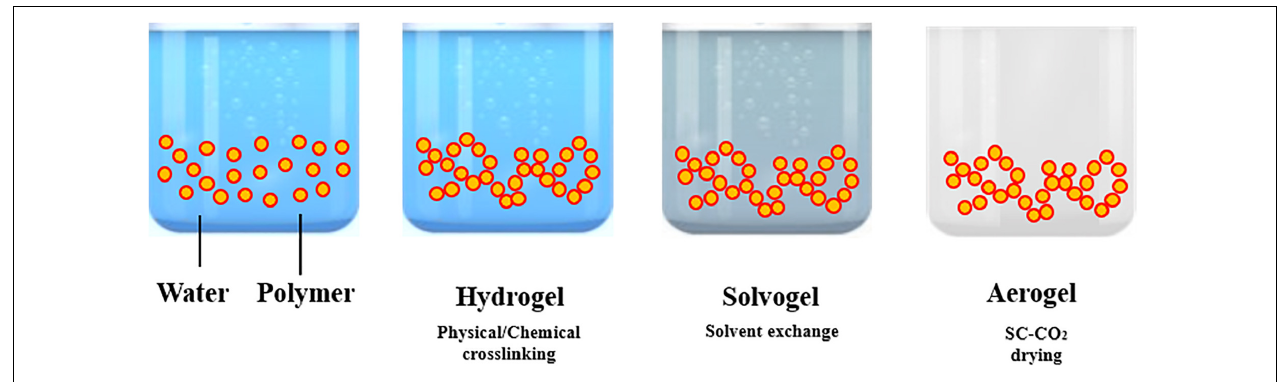
FIGURE 1 | Aerogel production